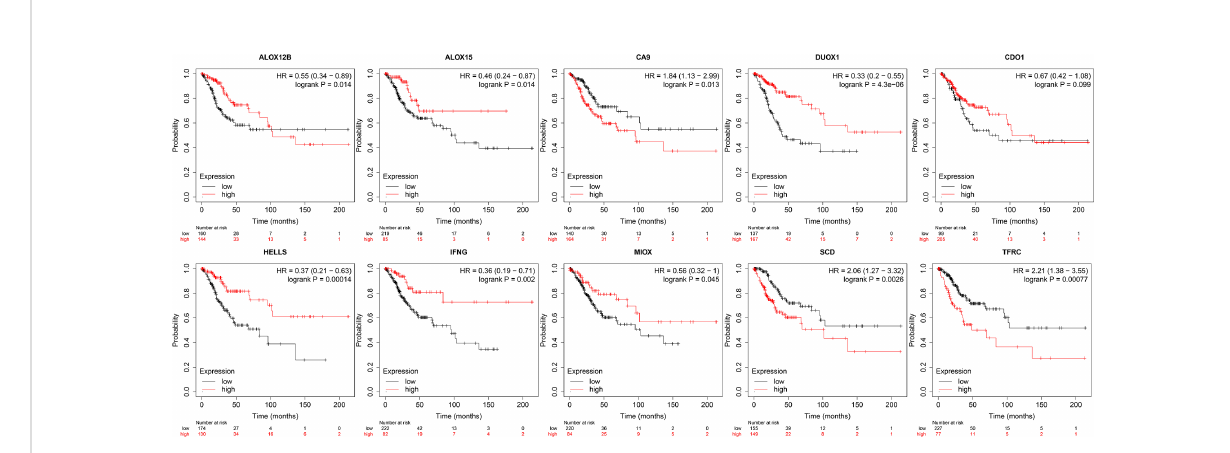
FIGURE 4 Kaplan-Meier curves of 10 prognostic genes. From left to right: the 1st row shows K-M curves of ALOX12B, ALOX15, CA9, DUOX1, CDO1; the 2nd row displays the K-M curves of HELLS, IFNG, MIOX, SCD, TFRC.